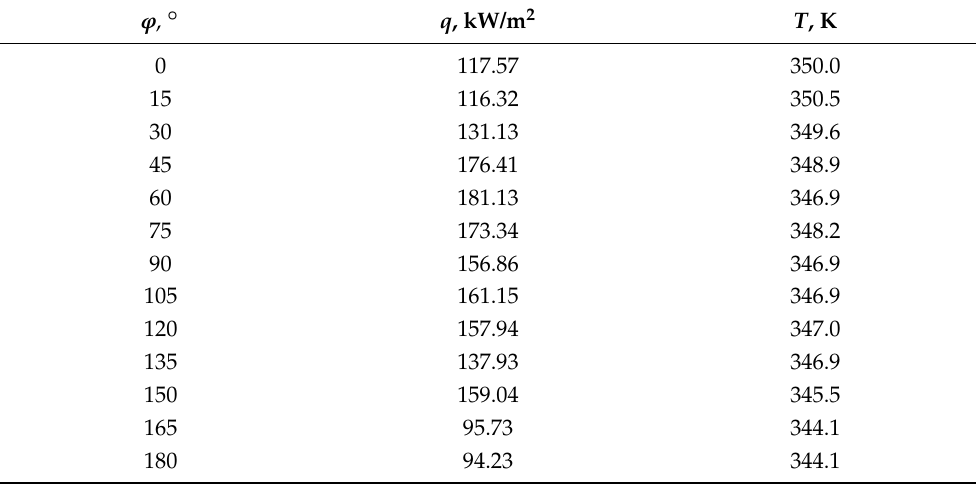
Table 6. The time-averaged local heat flux and surface temperature along the pipe